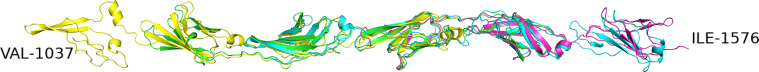
Possible fibronectin like structure of the B domain established as a superposition of four overlapping structures build by Swiss model using a monomer of 4p99 as template. Only the six last units of the nine (based on Figure 1) fibronectin like structures could be fitted to the 4p99 template and only the five last gave a complete fit to this structure. The four overlapping structures are colored in yellow, green, cyan, and magenta.